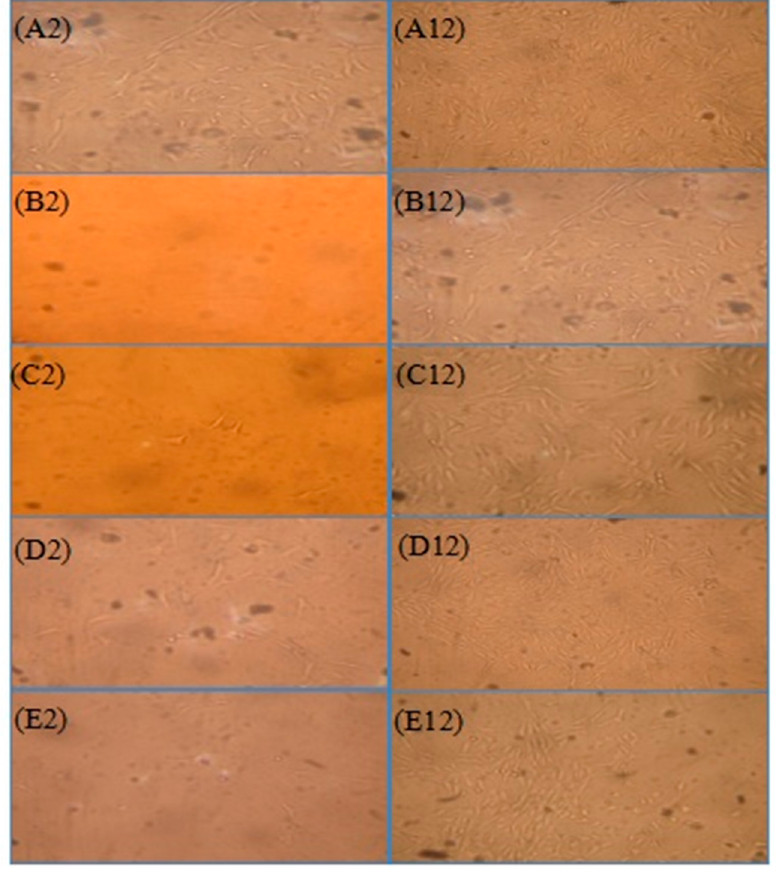
Figure 4. Effects of brucine gel on synoviocytes. Morphology of synoviocytes (magnification = 200×) in model group ( A2 , A12 ), blank control group ( B2 , B12 ), brucine gel high-dose group ( C2 , C12 ), brucine gel low-dose group ( D2 , D12 ) and Yunnan Baiyao powder group ( E2 , E12 ). Synoviocytes were isolated and cultured on the 2nd day ( A2 , B2 , C2 , D2 , E2 ), and on the 12th day ( A12 , B12 , C12 , D12 , E12 ).